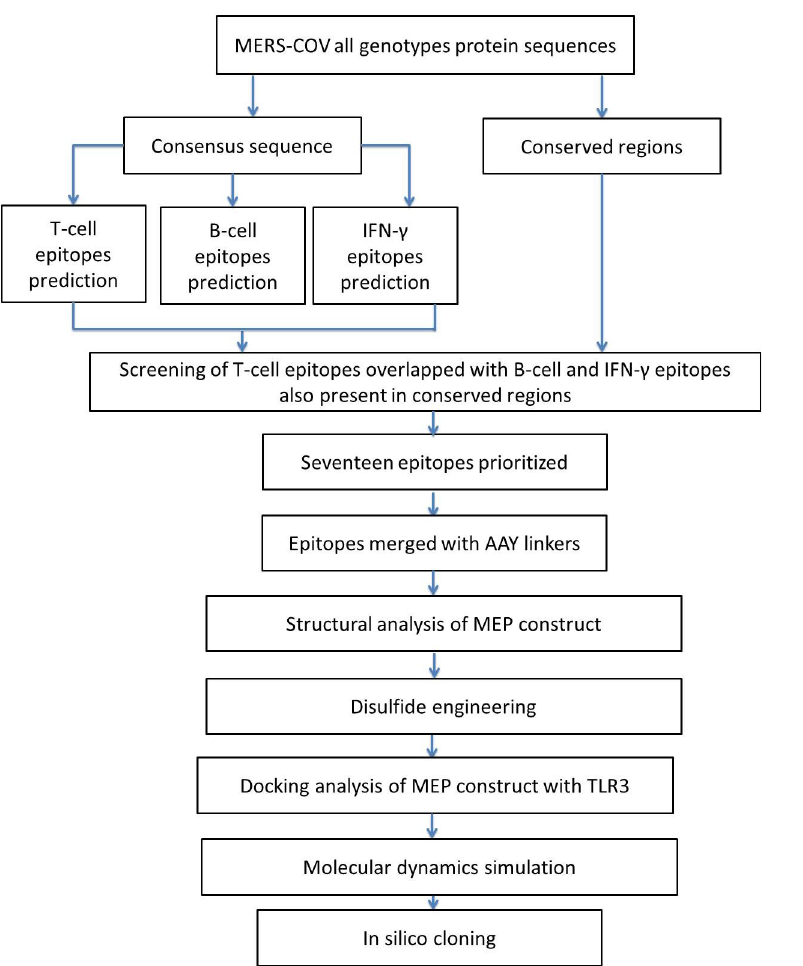
Fig 1. Overflow of complete work for vaccine construction. 1ab, NS3/3B/3C/3D/4A/4B/5, ORF3/4a/4b/5/8, membrane, nucleoprotein, spike, and envelope). (2) T-cell epitopes selection that is also present in conserved areas with expected B and IFN- γ epitopes. (3) Unification of selected epitopes using an appropriate linker & adjuvant to create MEP against MERS-COV with the help of structural modeling & epitope-epitope interactions depending on epitope combinations (4). The vaccine is characterized by TLR-3 molecular docking. The workflow of the work was shown in the Fig 1 . Firstly, the proteome of MERS-COV was studied via literature [6]. Amino- acid sequence of structural (spike (AKL59401), membrane (AKL59407), Envelope (AKL59406) and nucleocapsid (AKL59408)) and non-structural proteins (ORF1a (A0A2P1ITC7) /1ab (A0A140AYZ4), NS3/3B/3C/3D/4A/4B/5, ORF3 (K9N796) /4a (K9N4V0) /4b (K9N643) /5 (K9N7D2) /8 (A0A0U2GQ91)) [8, 22] were obtained from Uniprot database in the FASTA format [23].